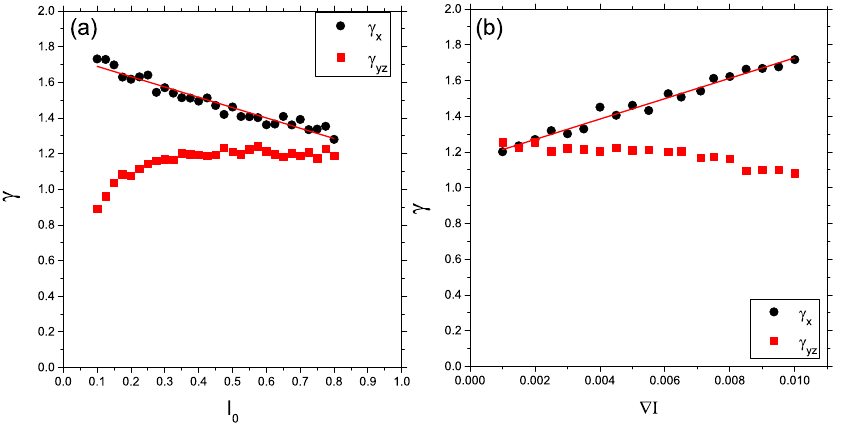
Figure 9. Plot of exponents γ x (black circles) and γ y , z (red squares) as functions of intensity offset I 0 for ∇ I = 0.005 ( a ) and of gradient of intensity ∇ I for I 0 = 0.5 ( b